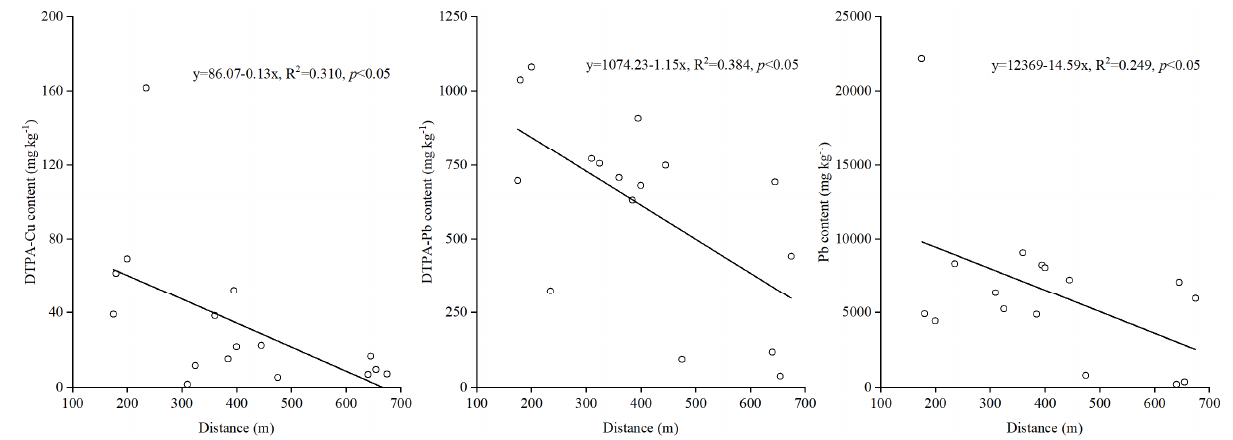
Figure 3. Linear regression analysis between heavy metal contents in sediment and the distance from the sampling sites to the mine holes.